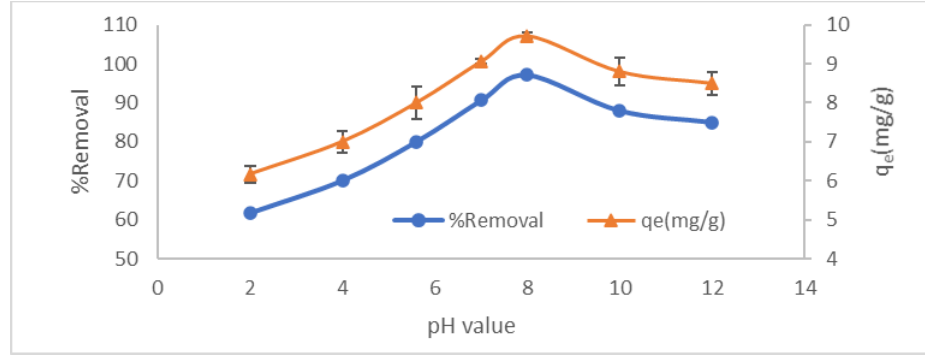
Figure 13. Effect of pH on % removal and LCF adsorption capacity.